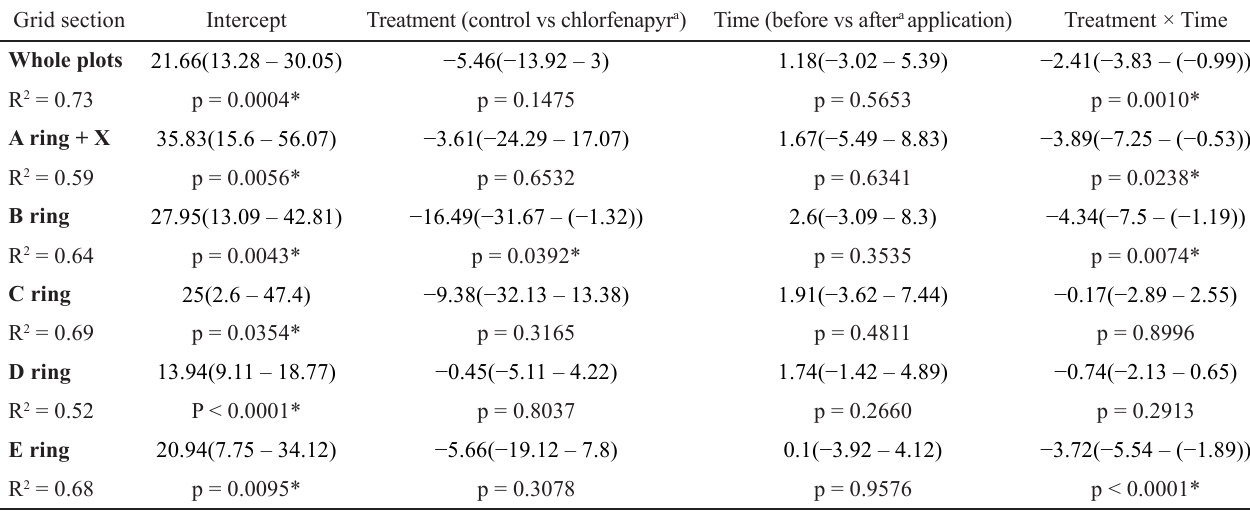
Table 4 . Results of mixed-effects multiple linear regression models for differences between control and chlorfenapyr-treated experimental grids based on the percentage of stations occupied by H. aureus . Parameter estimates are displayed with their 95% confidence intervals. For the interaction term, positive parameter estimates imply higher percentages of stations occupied by H. aureus relative to controls after treatment, while negative values imply a decrease. Only fixed effects are